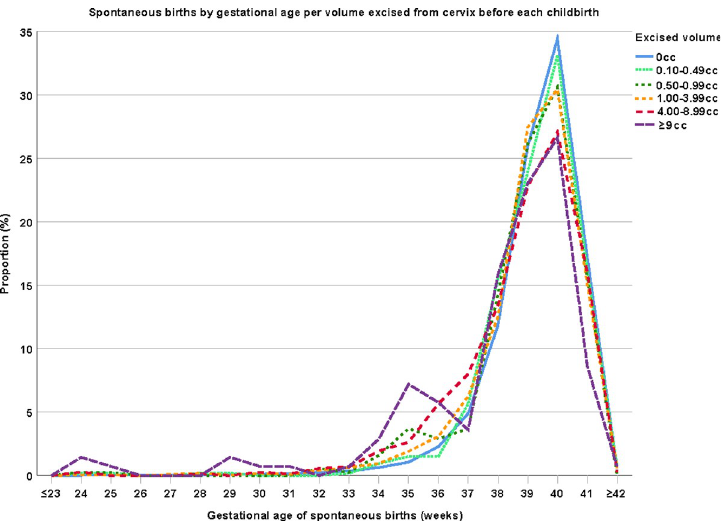
Fig 2. Spontaneous births by gestational age per volume excised from cervix before each childbirth. The distribution between the groups was statistically significantly different for 0 cc vs 1.00–3.99 cc ( P < 0.001), 0 cc vs 4.00– 8.99 cc ( P < 0.001), 0 cc vs � 9 cc ( P < 0.001), 0.10–0.49 cc vs 4.00–8.99 cc ( P = 0.005), 0.10–0.49 cc vs � 9 cc ( P = 0.004), 1.00–3.99 cc vs 4.00–8.99 cc ( P = 0.005), 1.00–3.99 cc vs � 9 cc ( P = 0.008) (two-sample Kolmogorov– Smirnov test). CIN, cervical intraepithelial neoplasia.